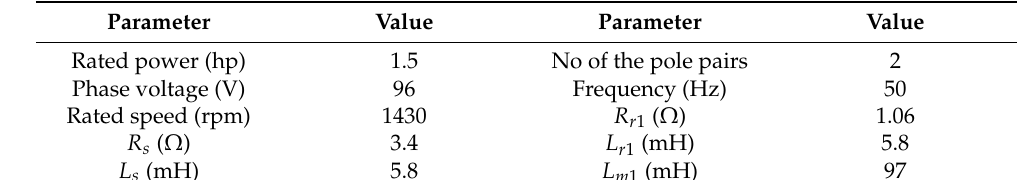
Table 7. Simulation Parameters.